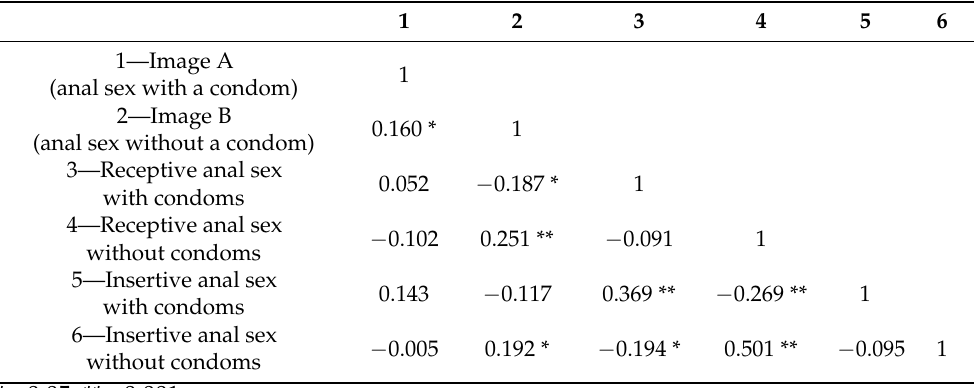
Table 5. Correlation Matrix between Images A and B and Anal Sexual